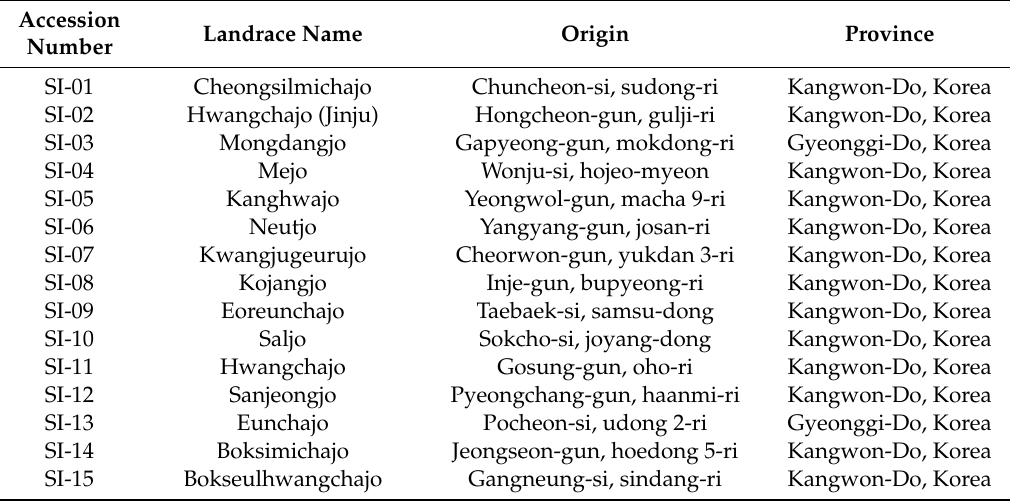
Table 1. Geographical location of accessions used in the